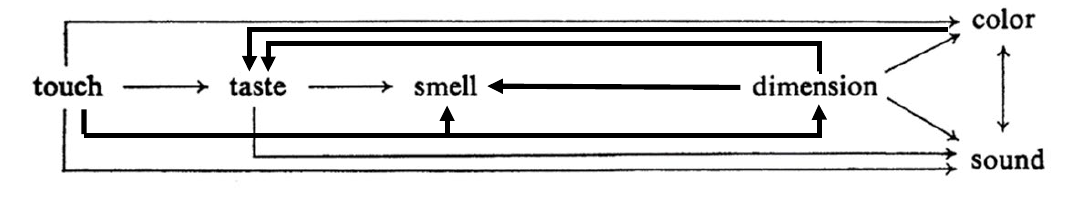
Fig.4. – Williams’ generalisation